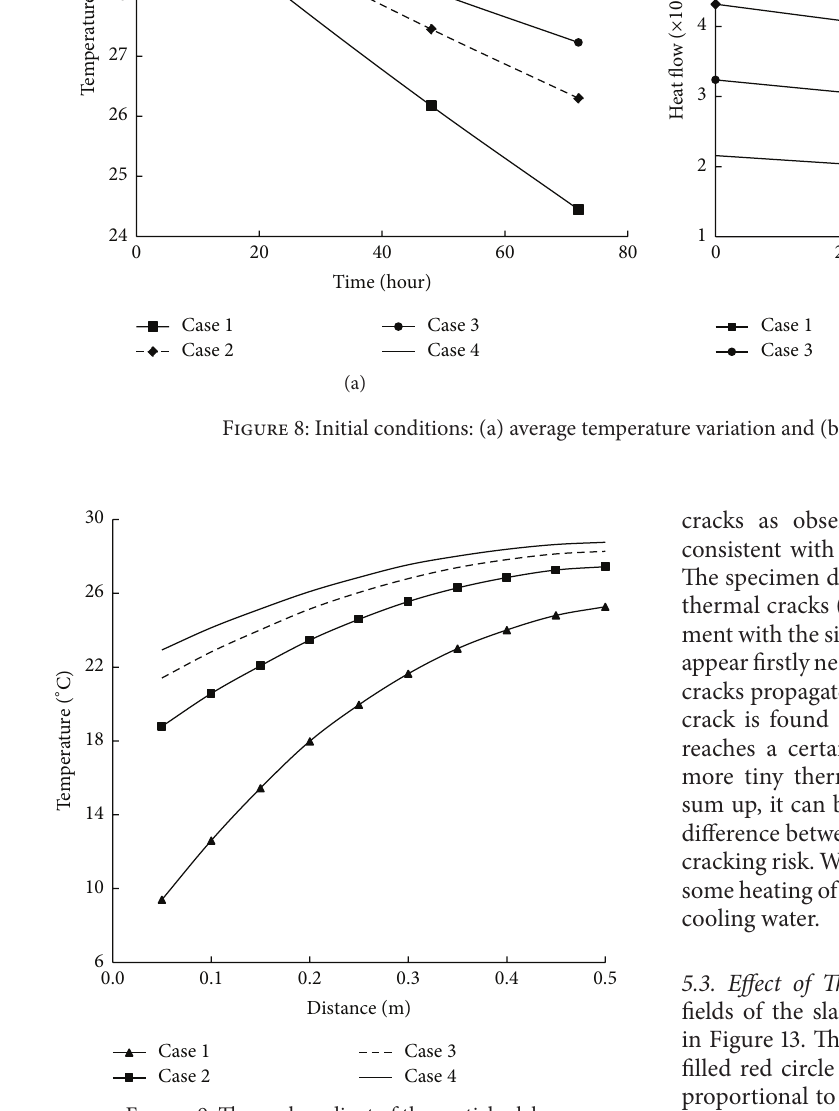
Figure 9: Thermal gradient of the particle